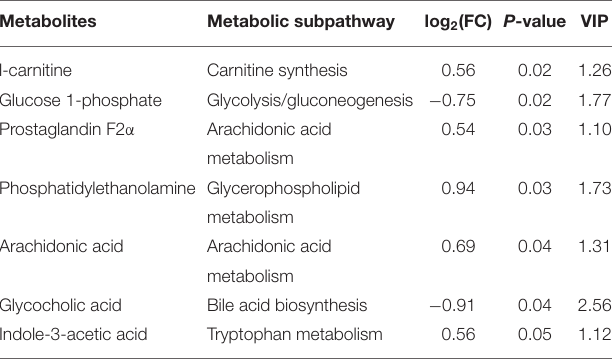
TABLE 3 | Differential metabolites in the liver between the CON and SPH